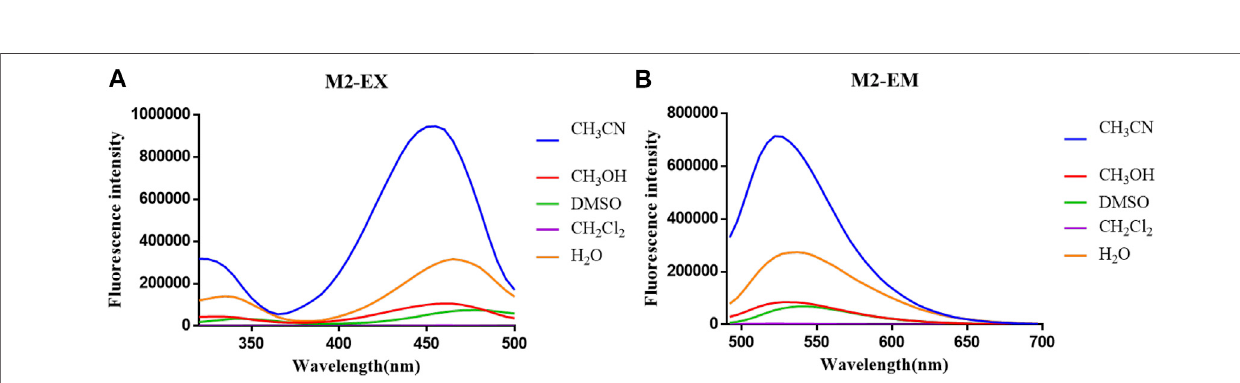
FIGURE 3 | (A) Fluorescent excitation and (B) emission spectra of probe M2 in different solvents.